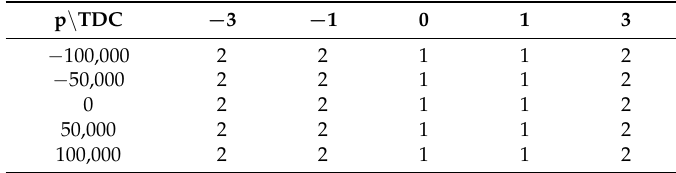
Table 10. Number of iterations for the MAN engine and operating point 2400 1/min and 373 Nm using the off-line